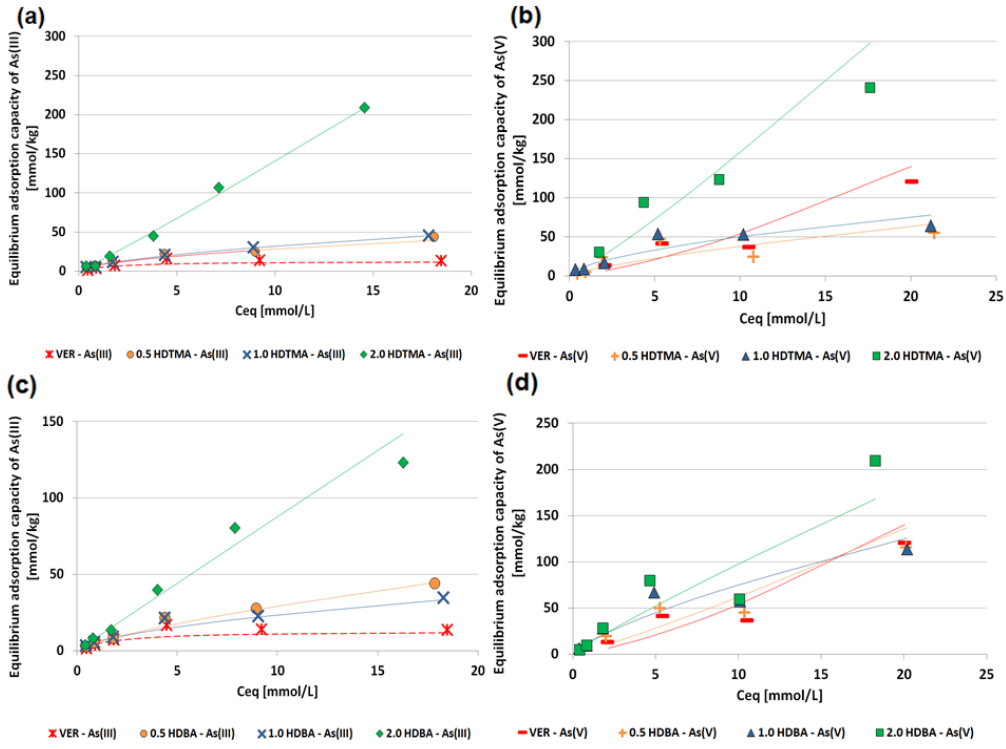
Figure 11. Sorption isotherms of: VER, 0.5 HDTMA, and 2.0 HDTMA for As(III) ( a ) and for As(V) ( b ); VER, 0.5 HDBA, and 2.0 HDBA for As(III) ( c ) and for As(V) ( d ). The curves that best fit the Langmuir (dotted line) and Freundlich (solid line) models are presented.